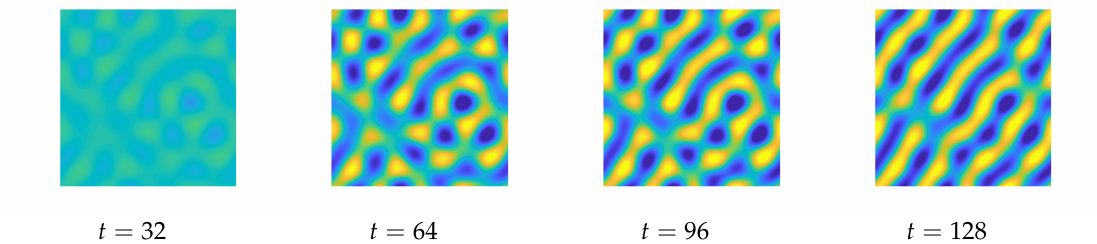
. In each snapshot, the yellow, green, 4 0.3420, respectively. −